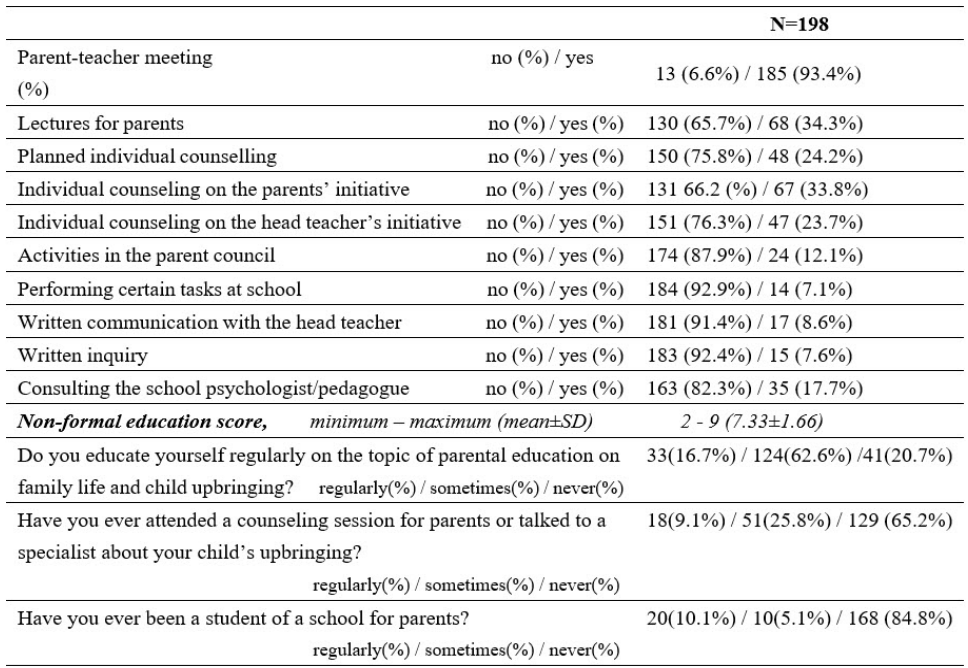
Table 2. The forms non-formal education within schools in which the parents participated the most, descriptive